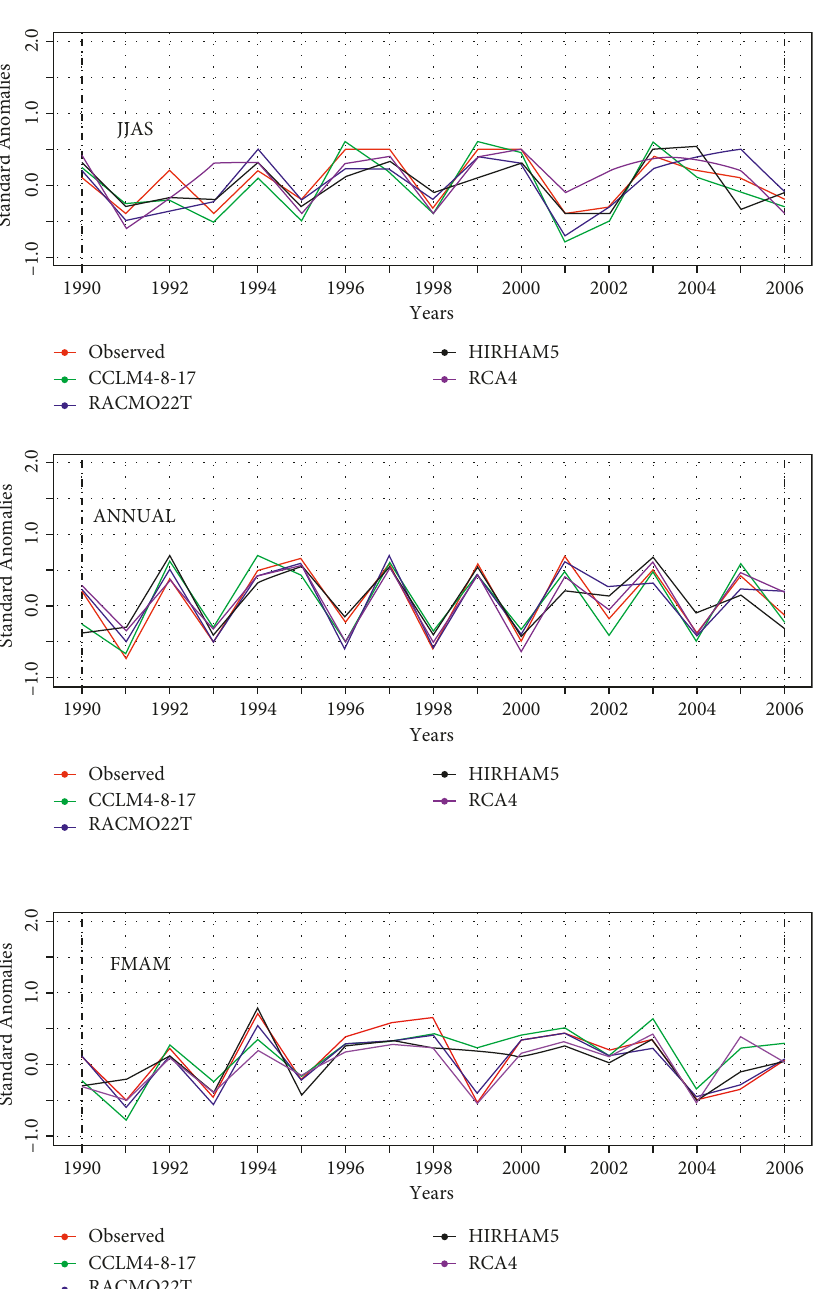
Figure 13: Interannual variability of standardized maximum temperature anomalies over Akaki